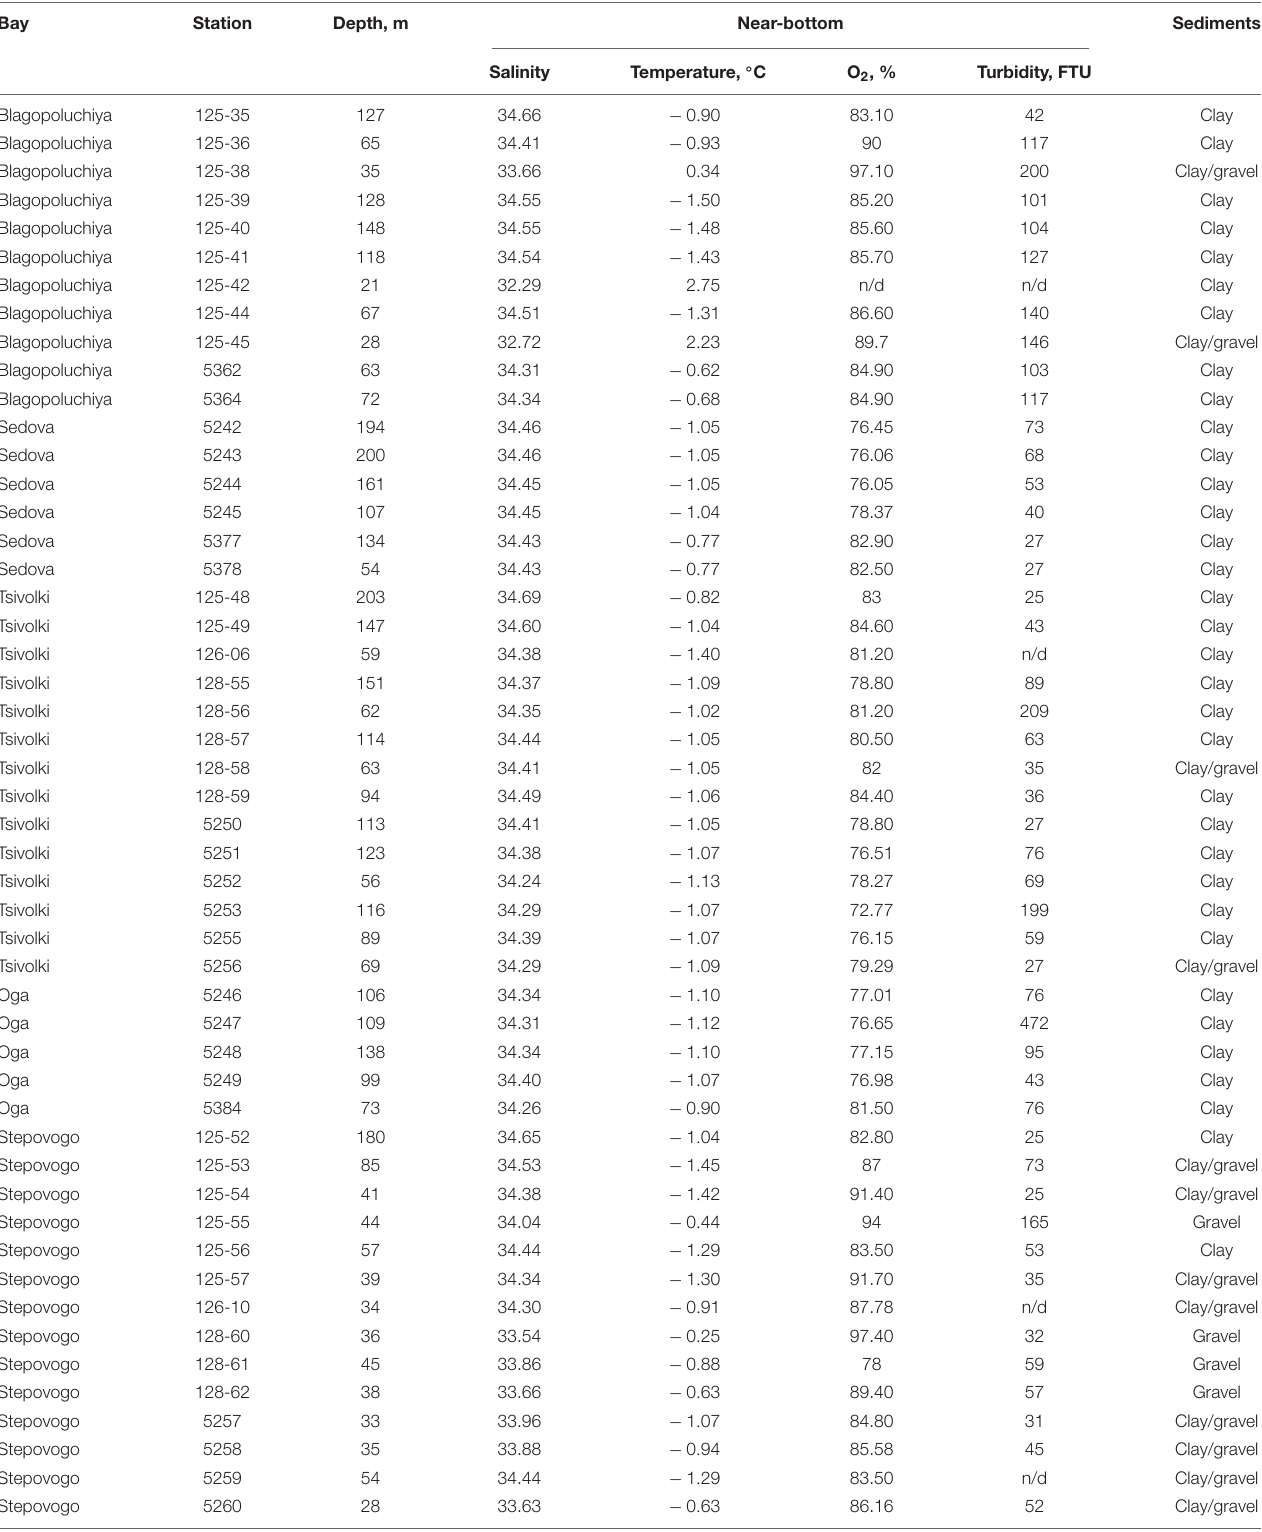
TABLE 1 | Environmental characteristics of the fjords